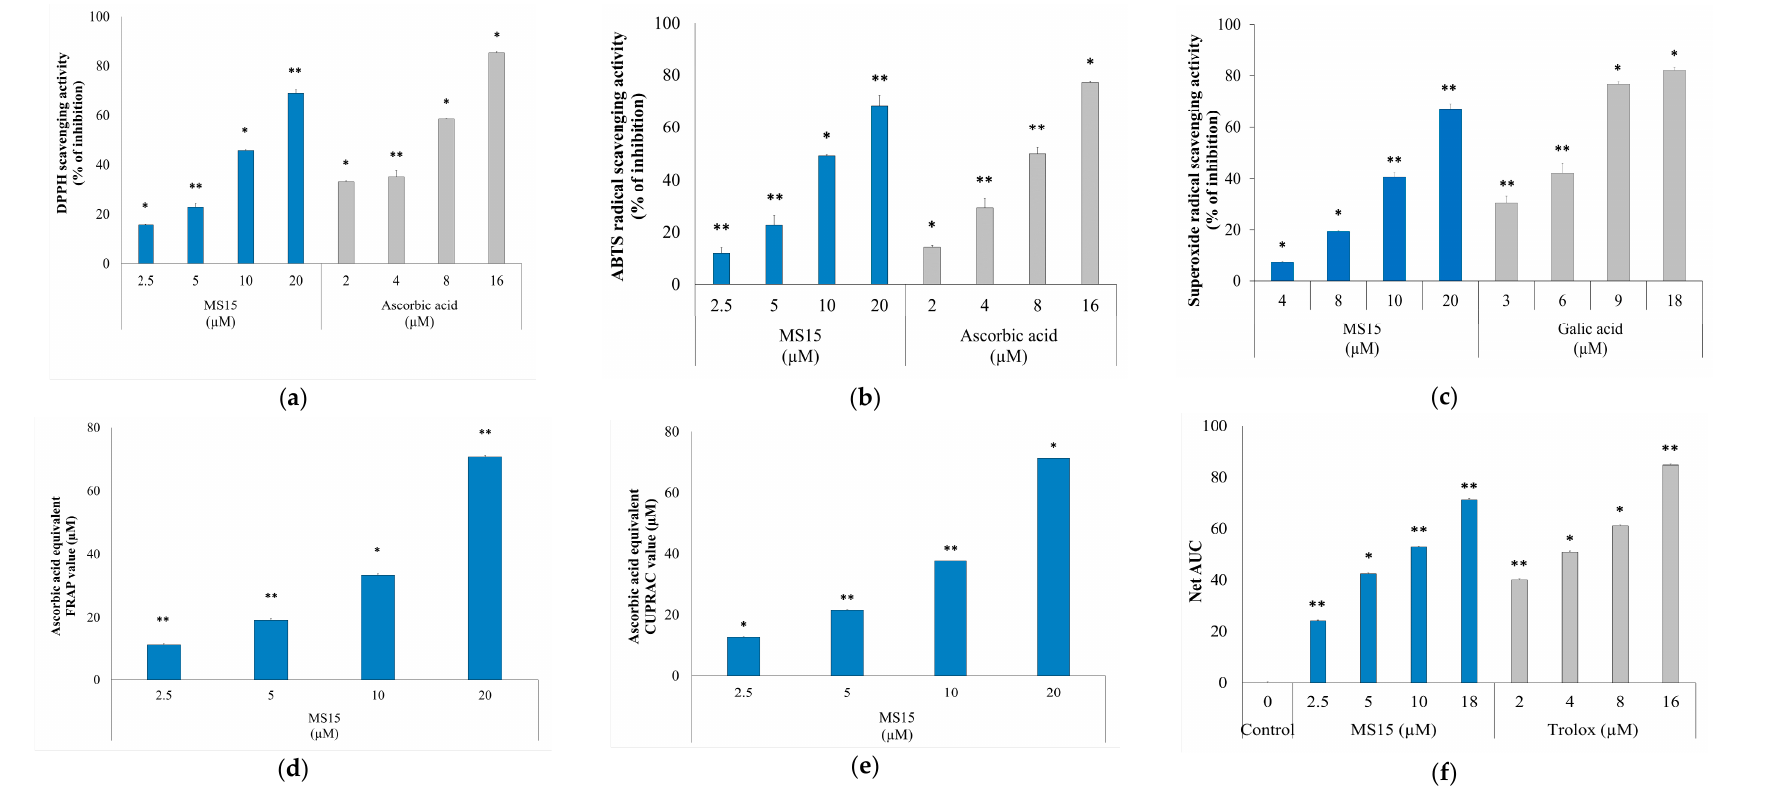
Figure 4. ( a ) The DPPH, ( b ) ABTS • + , and ( c ) SOD radical scavenging assay were performed with several concentrations. ( d ) FRAP assay and ( e ) CUPRAC assay were conducted with various concentrations of MS15, where ascorbic acid and gallic acid were assessed as a standard antioxidant compound. ( f ) The net area under the curve (Net AUC) was obtained by subtracting the area under the blank curve from the area under the sample curve, which showed the ORAC properties of the samples. Applying the student’s t -test, significantly different from the control denoted as, ** p ˂ 0.01, * p ˂ 0.05.